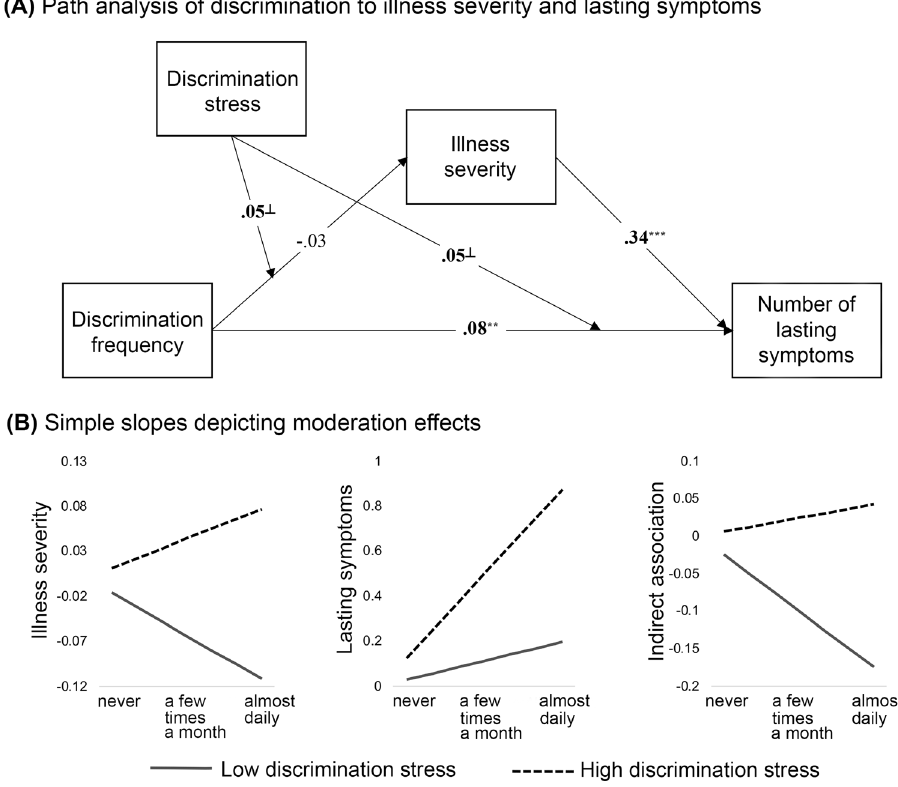
Fig. 3 The observed path model and simple slopes depicting moderation effects. Observed associations between discrimination frequency, illness severity and number of lasting symptoms, with moderation by discrimination stress are represented in A . Standardized coef fi cients are shown. On all pathways, we controlled for race, cumulative SES risk score, perceived SES score, history of mood/anxiety disorder, history of diabetes/heart disease, COVID-illness life disruption, COVID-illness anxiety, and early versus late illness onset (i.e., peak 1 versus peak 2). A summary of observed moderation effects is provided in B , plotting model-estimated standardized simple slopes for all values of discrimination frequency. The x -axis for B is discrimination frequency. Discrimination stress moderates the direct effects of discrimination frequency on illness severity and lasting symptoms (left and middle plot). Discrimination stress also moderates the indirect effect of discrimination frequency on lasting symptoms through differential impacts on illness severity (right plot). � p < .10, ** p < .01, *** p <